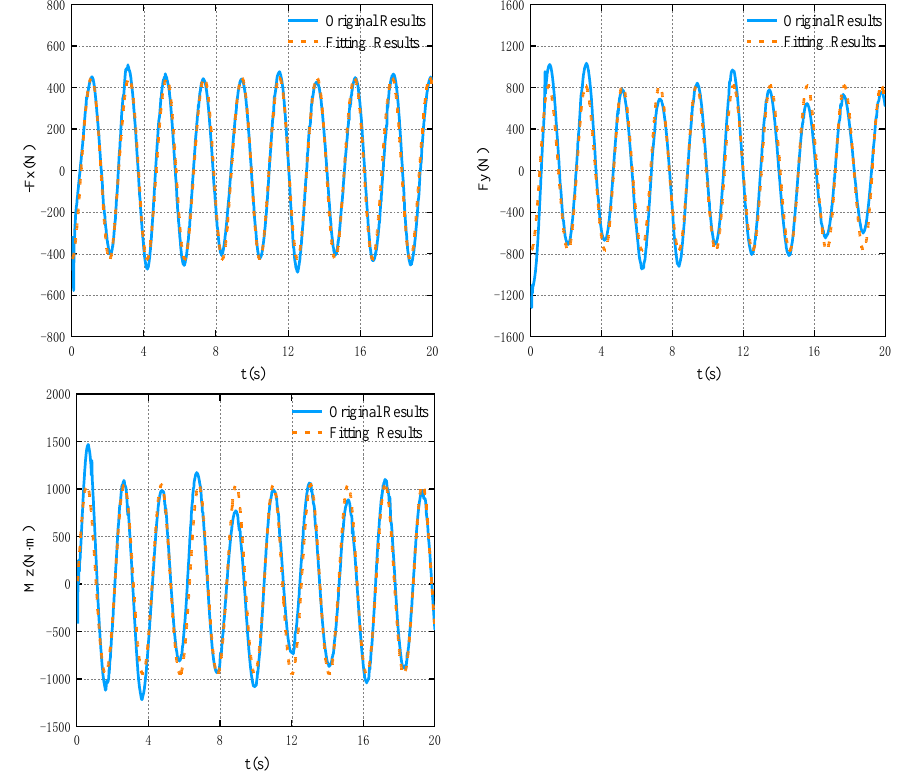
Figure 12. Least squares fitting of the surge, sway, and yaw forces and moment of KVLCC2 ship under H = 0.02 L PP , λ = 1.1 L PP , χ = 120°, β = 0°, and U = 6.0 kn.